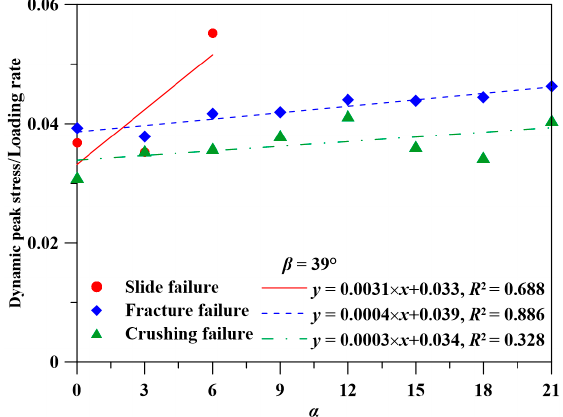
Figure 13. Change in DSLR with the angles, α , of specimen with β = 39°.